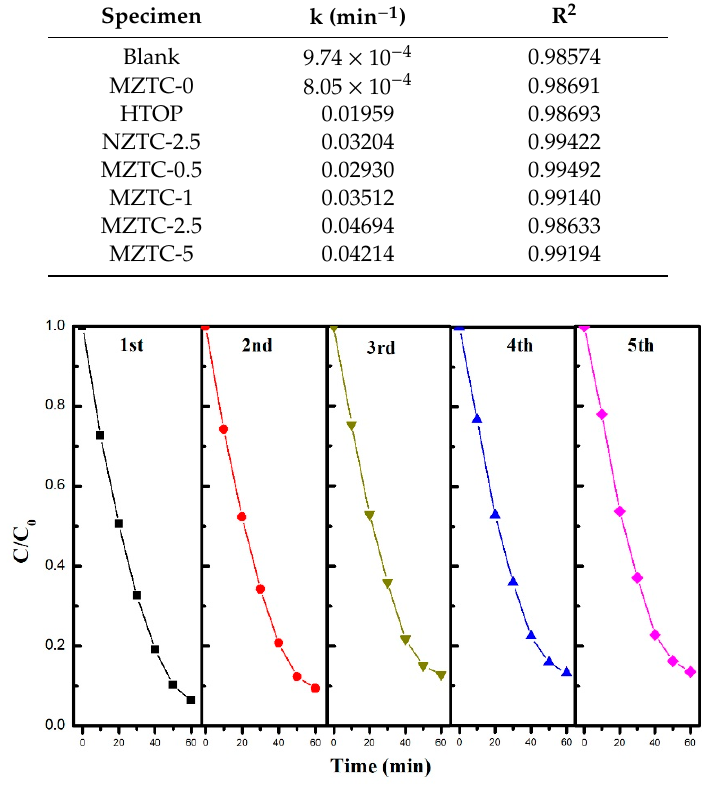
Figure 8. Results of the recycle degradation experiment of MZTC-2.5.